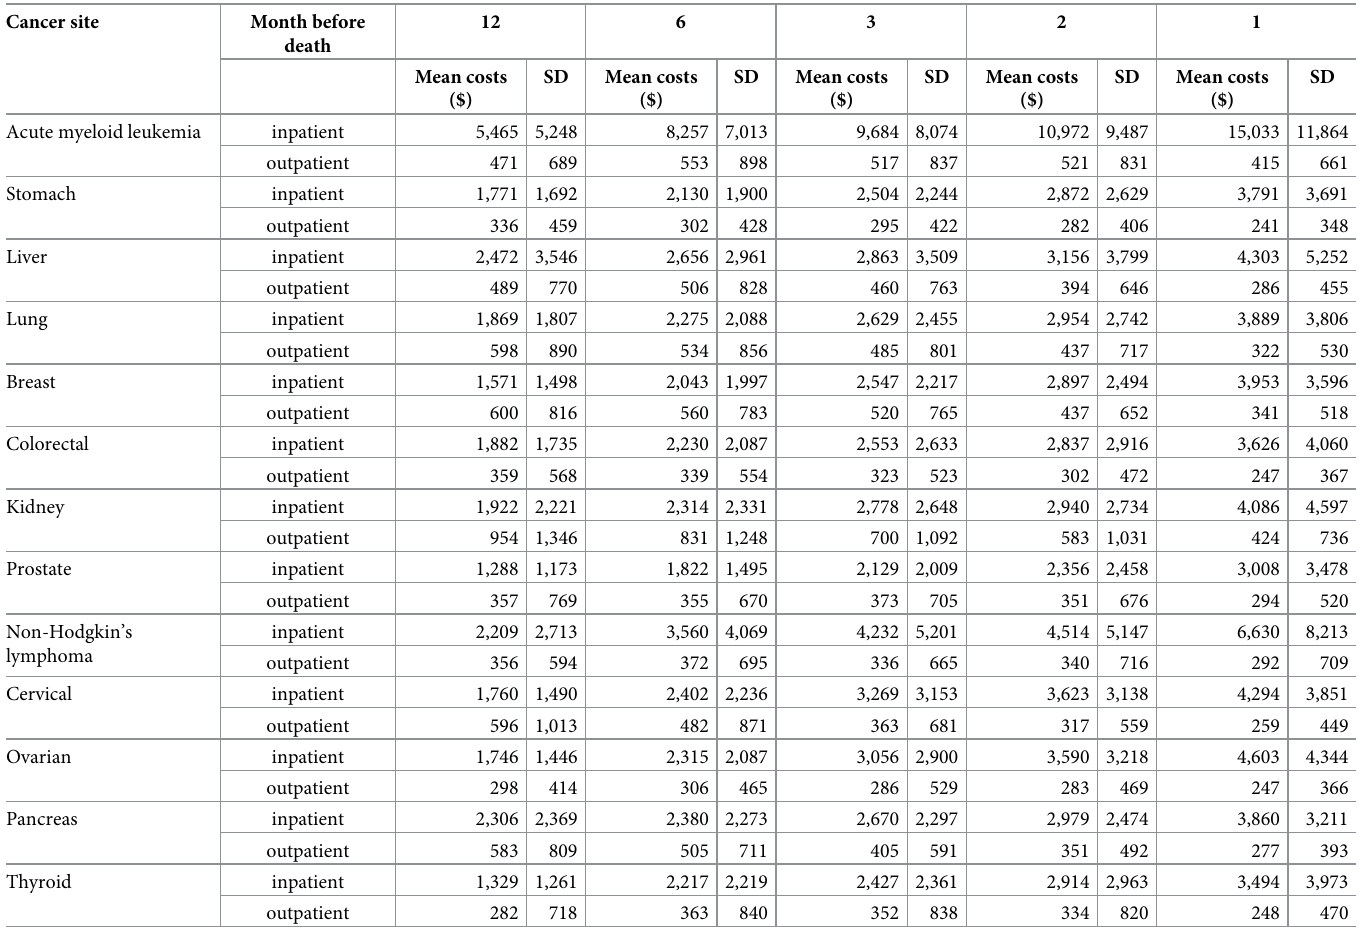
Table 3. Monthly inpatient and outpatient costs per patient with cancer in the last year of life. Cancer